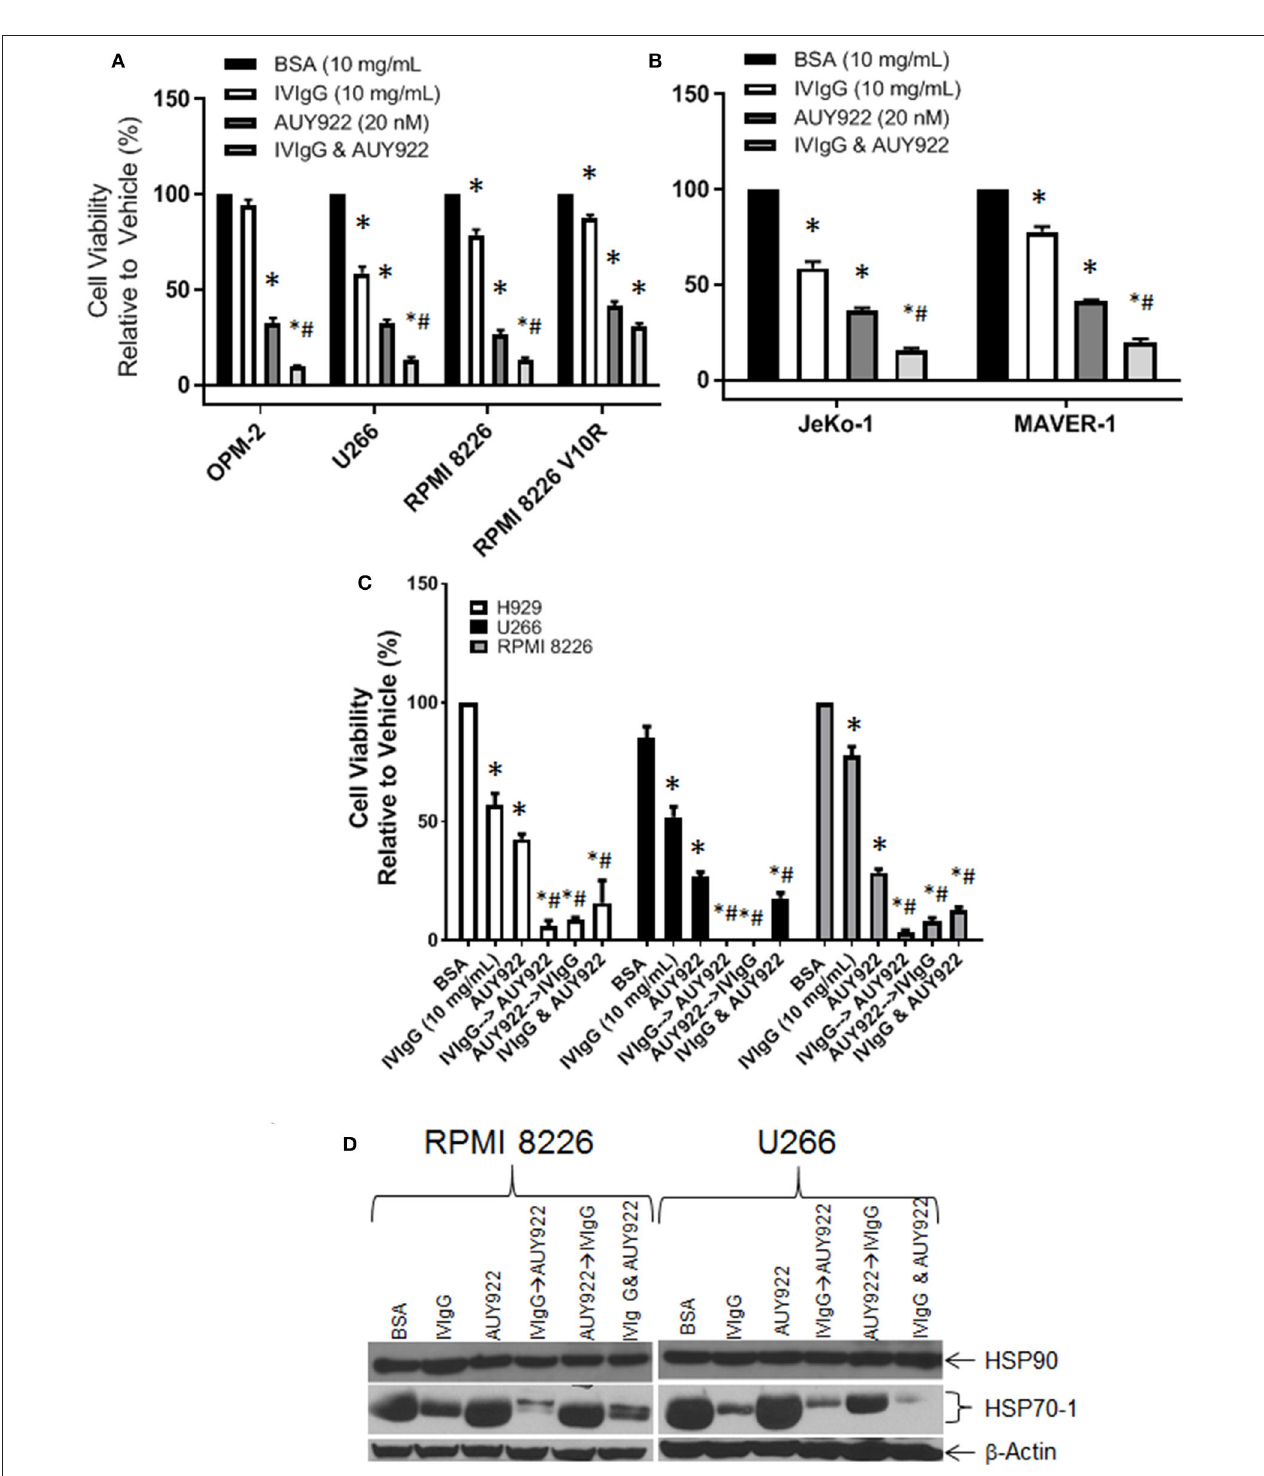
FIGURE 6 | IVIgG suppresses AUY-922-mediated induction of HSP70-1 leading to enhanced cell death when used in sequence-specific combinations. Myeloma (A) and MCL (B) cell lines were treated with BSA, IVIgG, or AUY922 alone, or IVIgG with AUY922 for 72h and cell viability was determined using the WST-1 assay. The BZB-resistant RPMI 8226 V10R cell line was also evaluated, along with its drug-naïve RPMI 8226 counterpart. (C) Cell viability measuring the sequence-specific effects of administration of IVIgG vs. AUY922 was then performed in myeloma cell lines, where IVIgG or AUY922 was added followed by the other agent 24h later and then the two drugs were incubated for an additional 48h. As a control, AUY922 and IVIgG were also added simultaneously. * denotes p < 0.05 to the BSA control and # denotes p < 0.05 to both single agents. (D) Cell lysates from cells treated in (C) were evaluated for the indicated targets by immunoblotting.